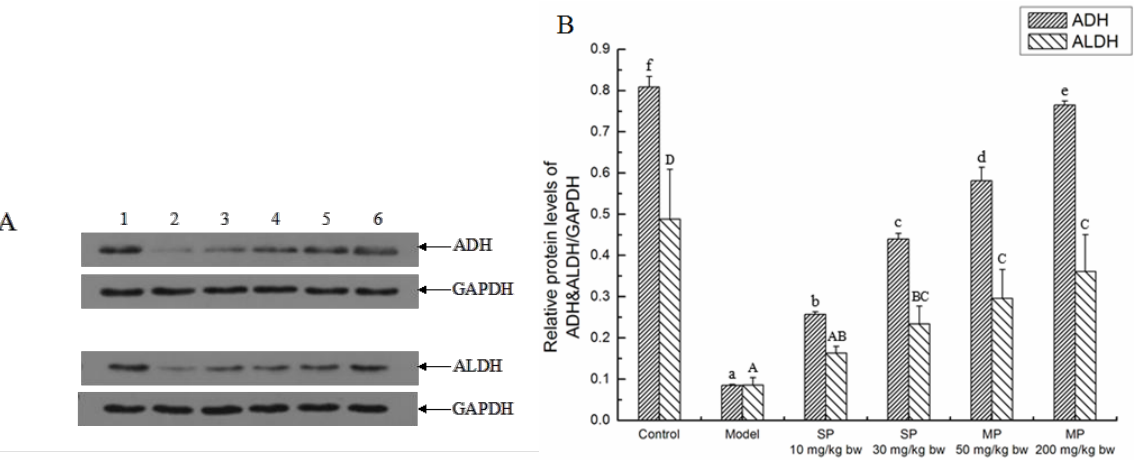
Figure 2. The relative protein expressions of ADH and ALDH in each group. ( A ) Representative western blots for ADH and ALDH, GAPDH was used as internal control for liver tissue; ( B ) Relative protein levels of ADH & ALDH/GAPDH. Values not sharing a common letter (a, b, c, d, e, f) differ significantly of relative protein level of ADH/GAPDH at p < 0.05. Values not sharing a common letter (A, B, C, D) differ significantly of relative protein level of ALDH/GAPDH at p < 0.05. SP, synthetic pentapeptide; MP, mixed corn peptides. Numbers 1–6 indicate groups of Control, Model, SP-10 mg/kg bw, SP-30 mg/kg bw, MP-50 mg/kg bw and MP-200 mg/kg bw,